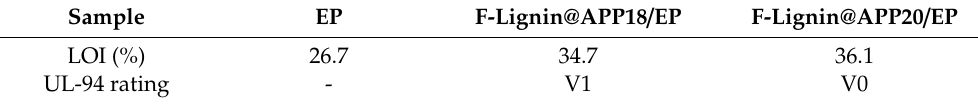
Table 2. Flame retardance of EP, F-lignin@APP18 / EP and F-lignin@APP20 / EP.